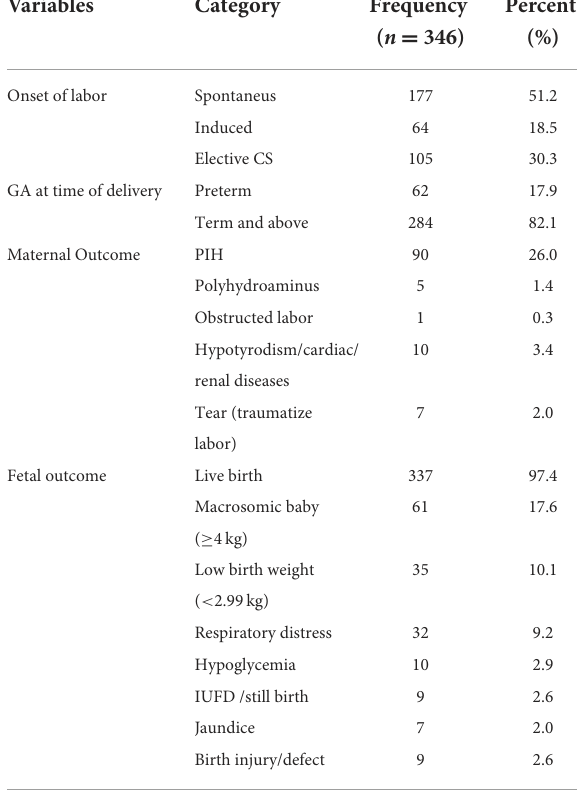
TABLE 2 Obstetrics history of diabetic mothers delivered at the Tikur Anbessa Specialized Hospital in Addis Ababa, Ethiopia, 2018. Variables